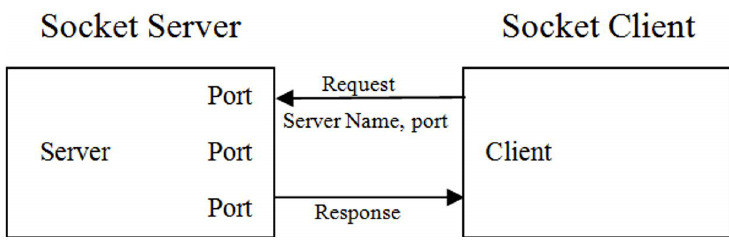
FIG. 2. THE SERVER INSTANTIATES A SERVERSOCKET OBJECT, THAT DENOTES ON WHICH PORT NUMBER COMMUNICATION CAN OCCUR ON. THE SERVER CALLS THE ACCEPT() METHOD OF THE SERVERSOCKET CLASS. THE METHOD WAITS UNTIL A CLIENT CONNECTS TO THE SERVER ON THE GIVEN PORT [13]